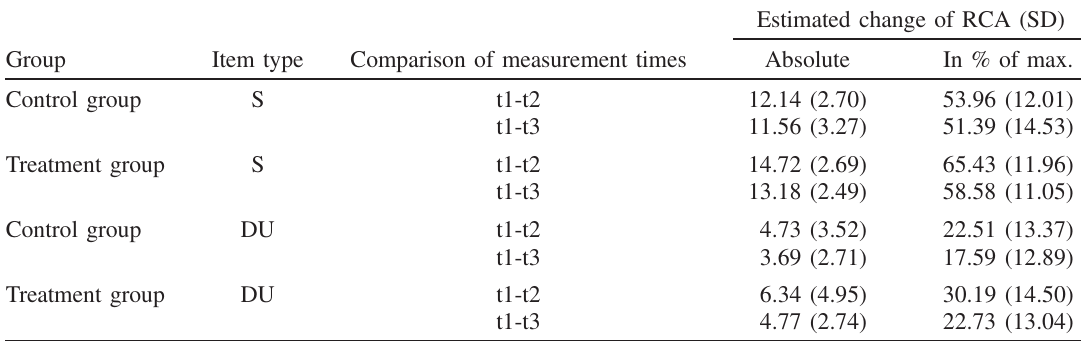
TABLE V. Estimated changes of RCA between pre- and post-test, and pre- and follow-up test, for S and DU items separately (multilevel model for measuring